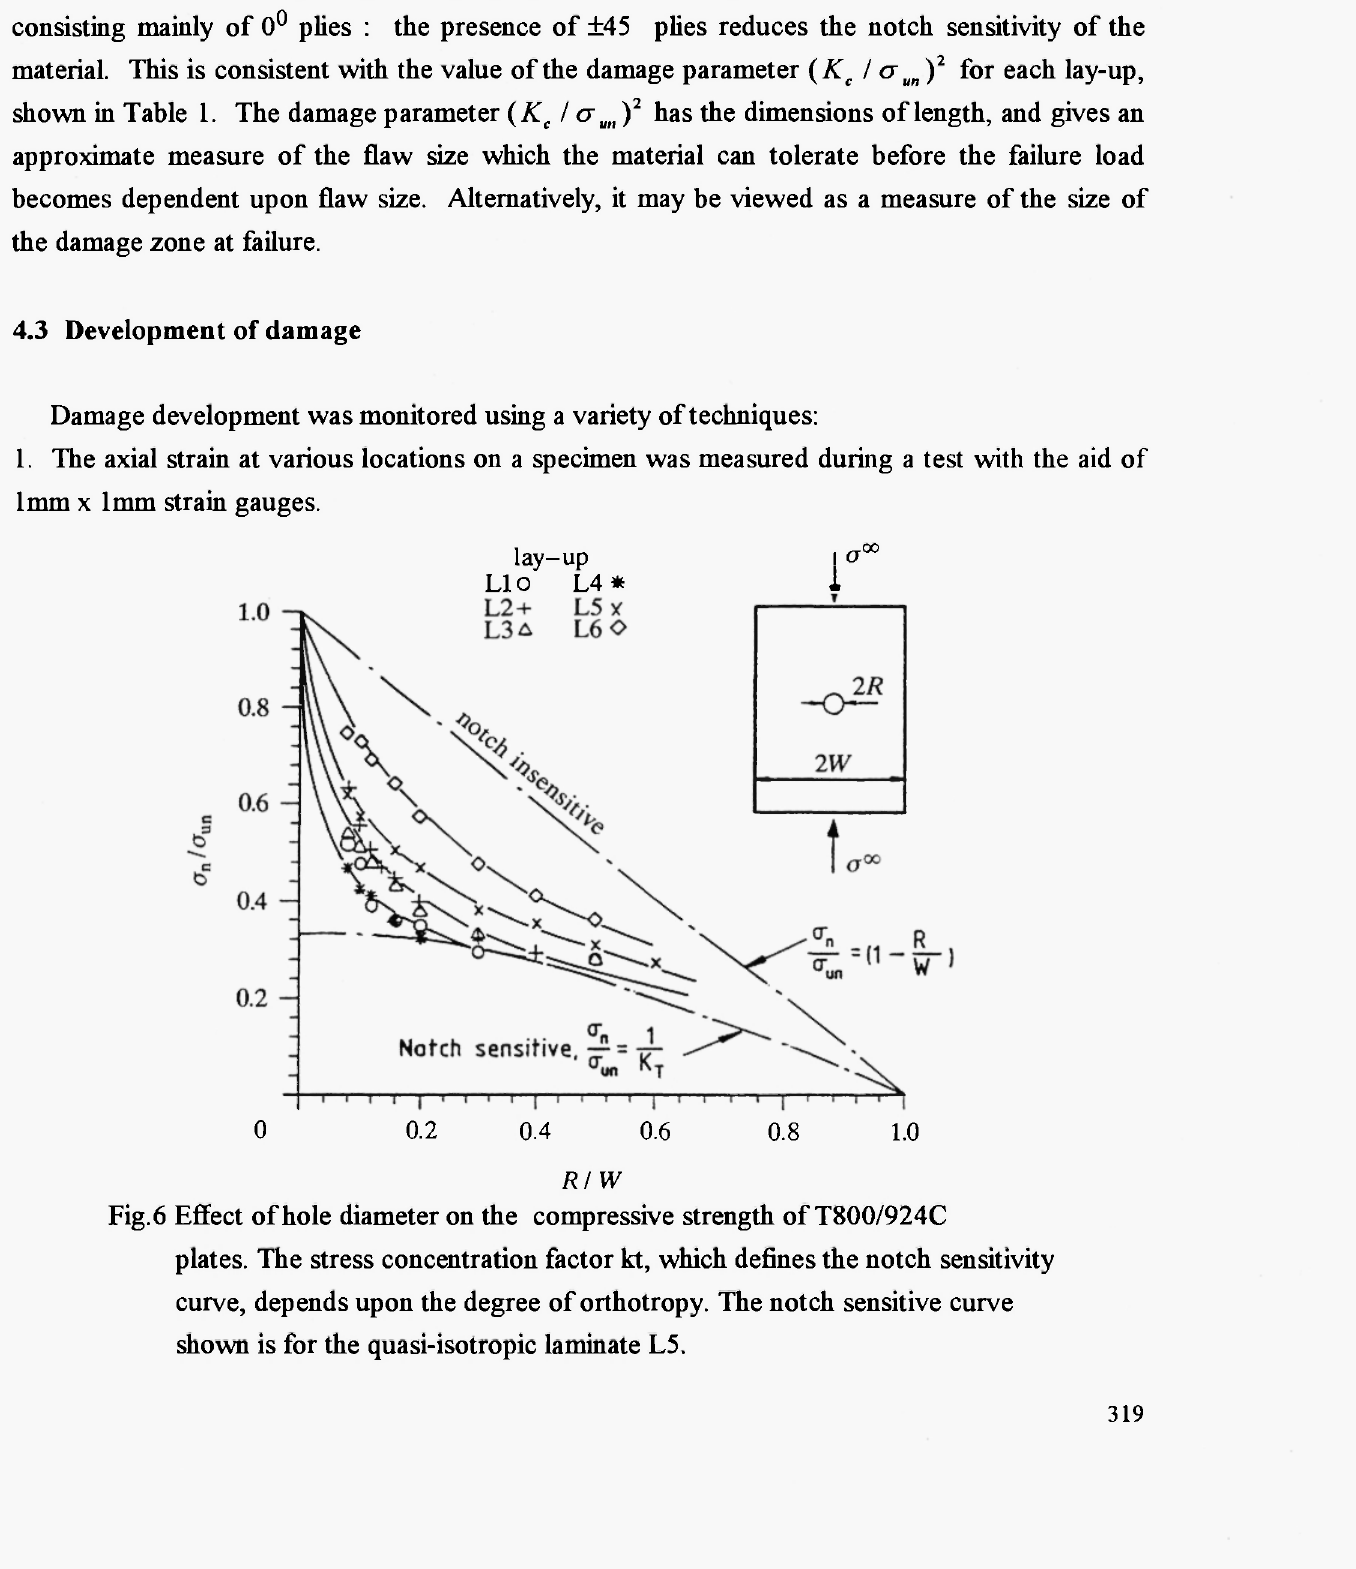
Fig.6 Effect of hole diameter on the compressive strength of T800/924C plates. The stress concentration factor kt, which defines the notch sensitivity curve, depends upon the degree of orthotropy. The notch sensitive curve shown is for the quasi-isotropic laminate